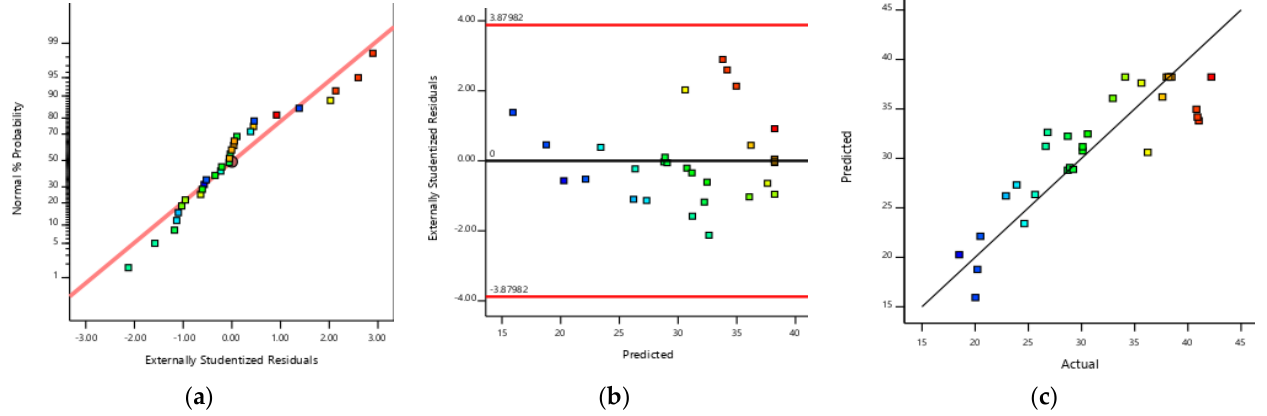
Figure 13. Residual diagnostic plots of the quadratic model of the inner flesh of straw. ( a ) Normal plot of residuals; ( b ) residuals vs. predicted; ( c ) predicted vs. actual.